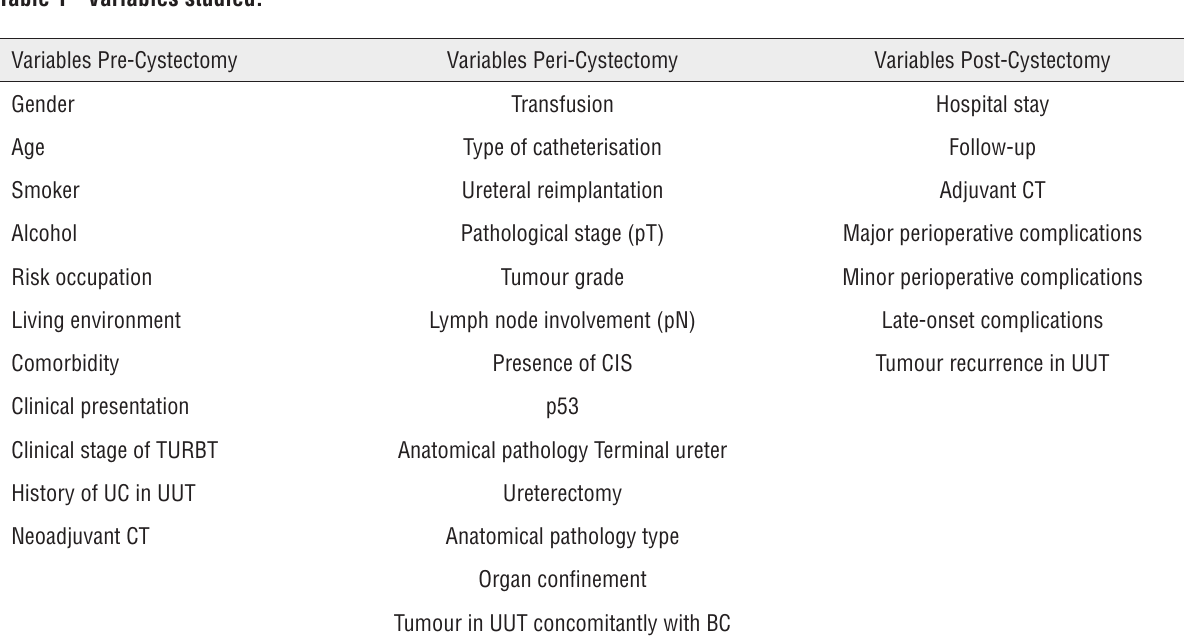
Table 1 - Variables